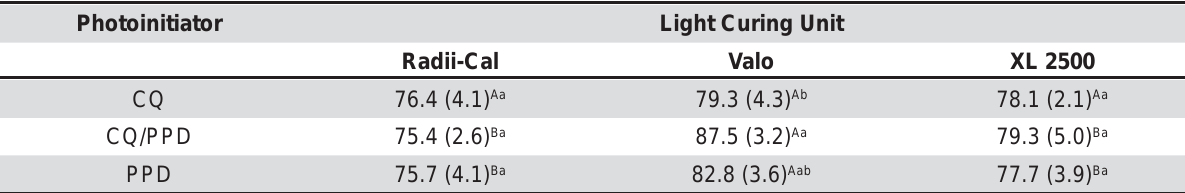
Table 1- Mean DC value (%) and standard error (±) provided for each of the photoinitiator systems